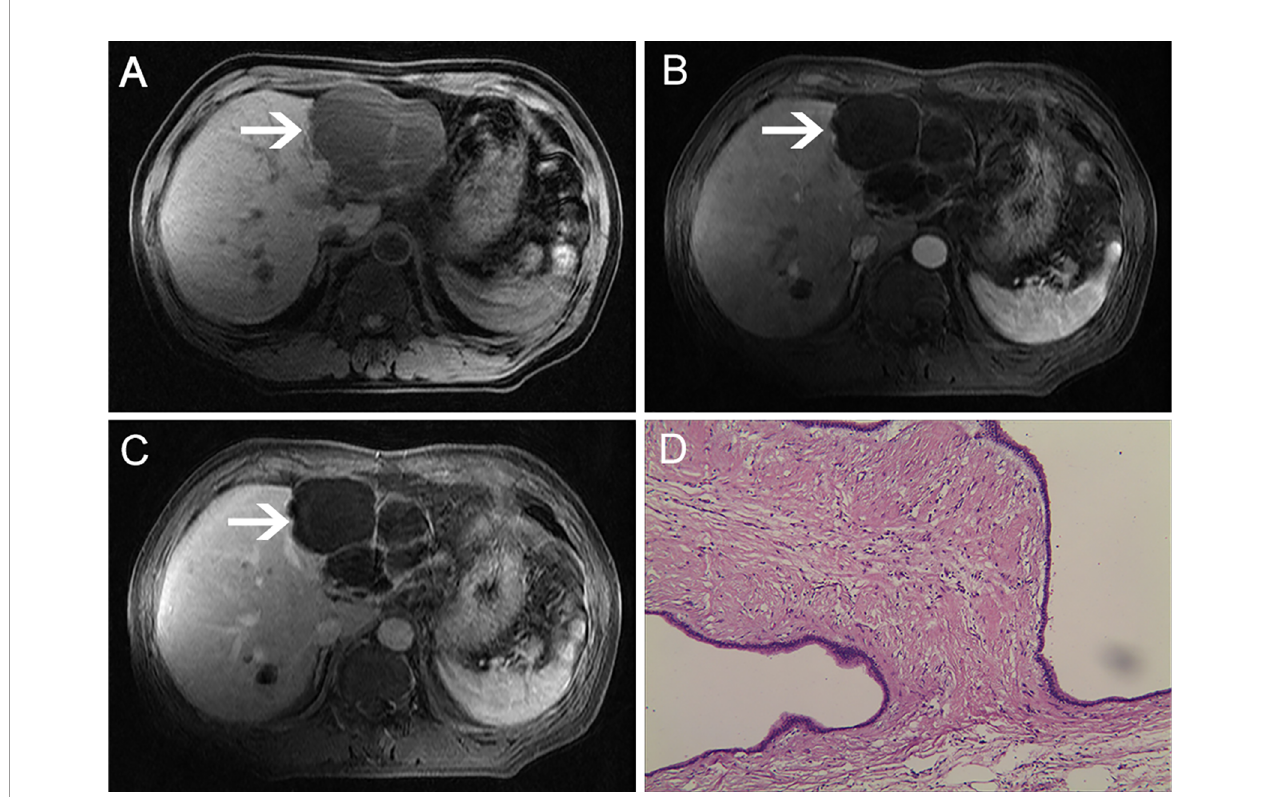
FIGURE 1 | MRI examination. The lesion showed low signals with multiple rooms on T1-weighted images. (A) Contrast-enhanced T1-weighted images showed no lesion enhancement: (B) arterial phase; (C) venous phase. (D) Microscopically, multiple cysts were observed. The inner wall of the cyst was covered with columnar mucous epithelium, the cytoplasm was slightly eosinophilic, and the nucleus was located at the base (HE